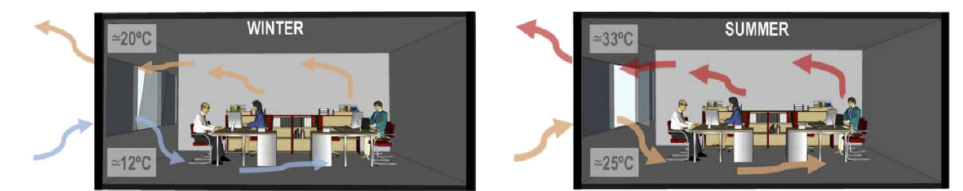
Figure 1. Single-sided natural ventilation of an office building in winter and summer [10].